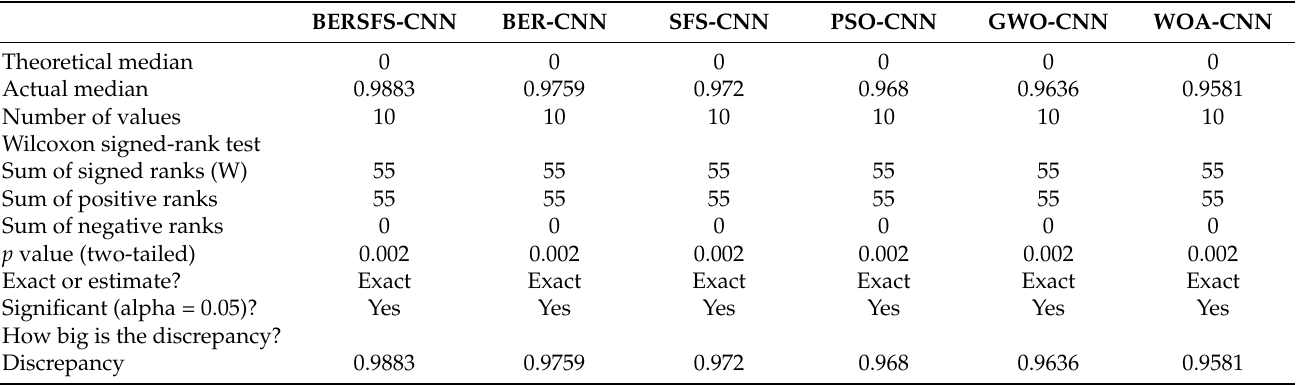
Table 13. Test results for the Wilcoxon signed-rank test of the BERSFS-CNN model and optimization- based